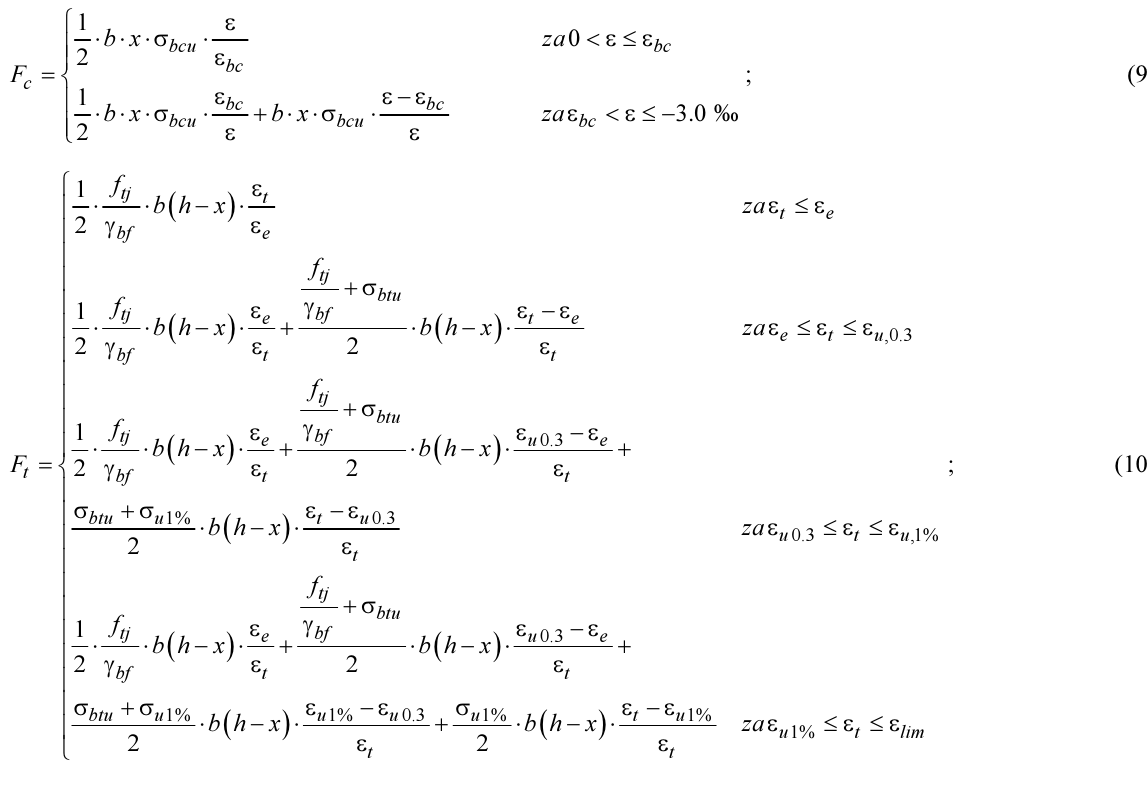
where γ bf is the partial safety coefficient (1.3 for basic load combinations, 1.05 for incidental load combinations). The total force in the pressed zone according to the specified model of behaviour is calculated as shown in